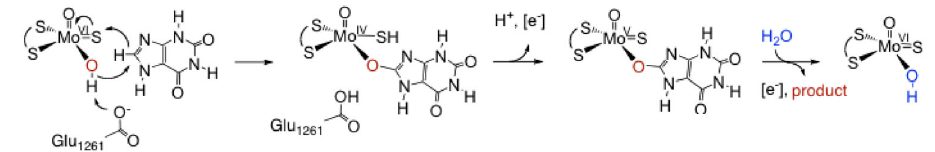
Figure 4. The reaction mechanism of xanthine oxidase.